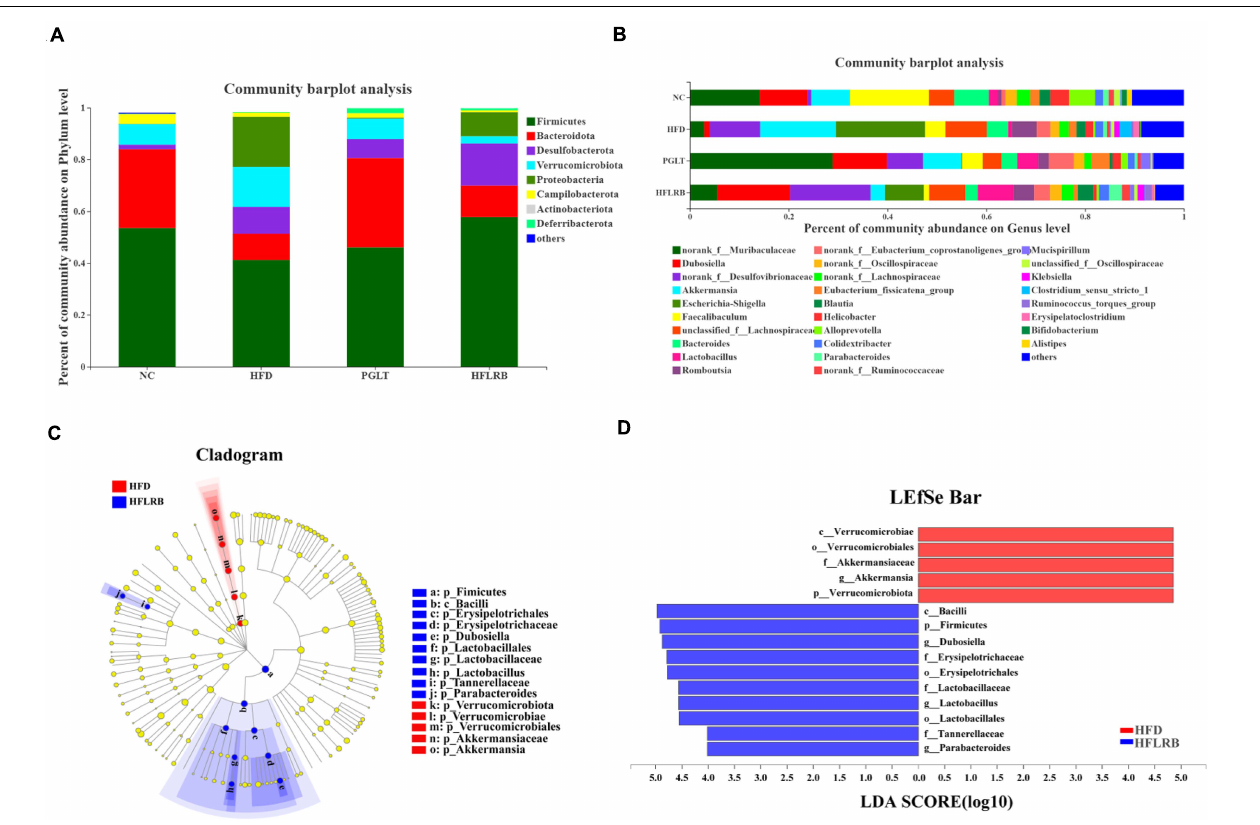
FIGURE 5 | The distributions of microbial community compositions in diabetic mice at the (A) phylum level and (B) genus level. The distributions at the genus level are shown as the average relative abundances of the top 30 genera in each sample. (C) The circle midpoint represents indicator bacteria with LDA scores greater than 4.0 in microbial groups. Yellow dots represent microbes with no significant differences among the 4 groups. (D) Histogram of LDA scores computed for differentially abundant microbes among the 4